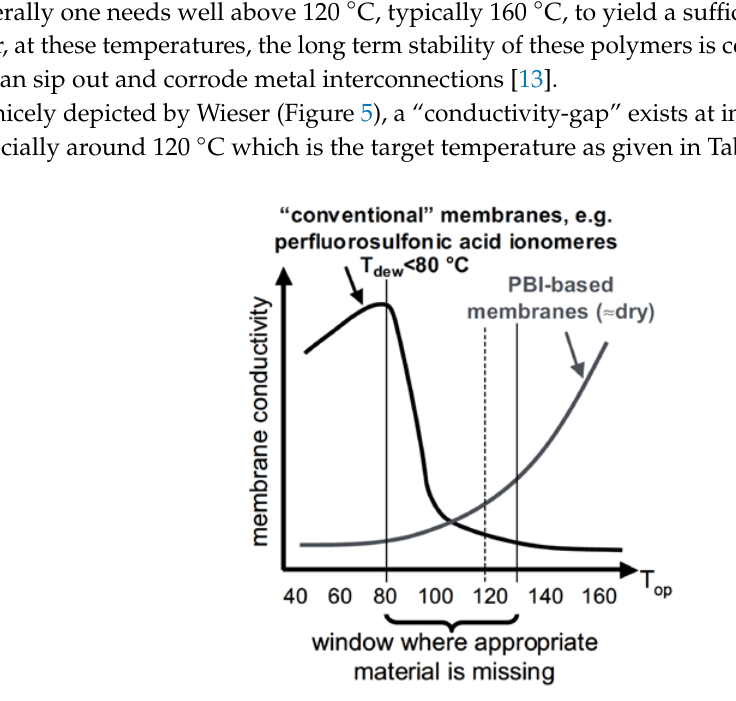
Figure 5. Membrane conductivity based on perfluorosulfonic acid (PFSA) ionomers and PBI, displaying the conductivity gap from 80 °C to 130 °C. Reprinted with permission from Ref. [28]. Copyright John Wiley & Sons, Ltd.